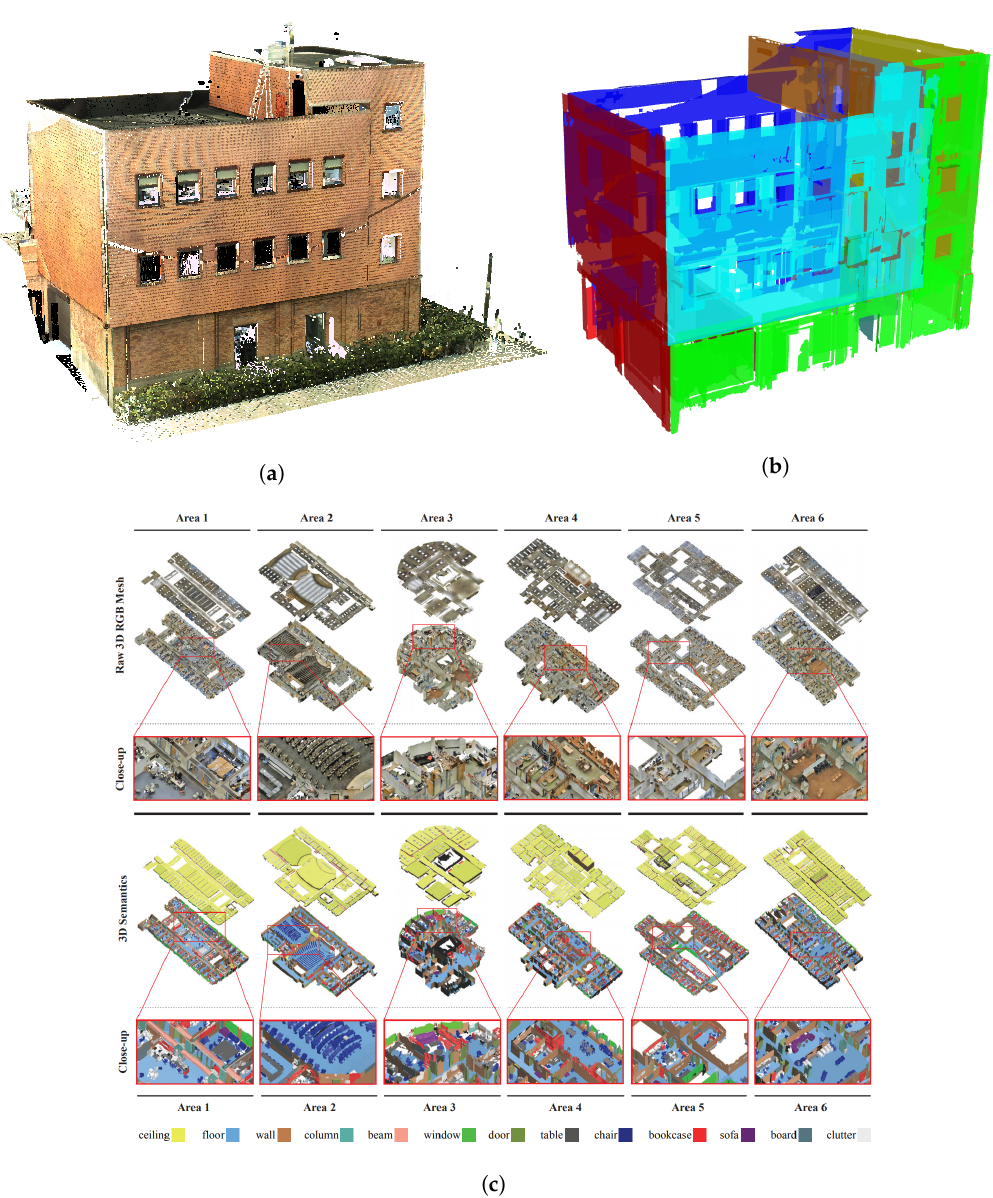
Figure 5. Test data sets for the conditional random fields clustering experiments. ( a ) Technology campus Ghent point cloud data; ( b ) Ground truth walls in a separate color; ( c ) 2D-3D-Semantics (2D-3D-S) benchmark data of Stanford including colored and annotated meshes